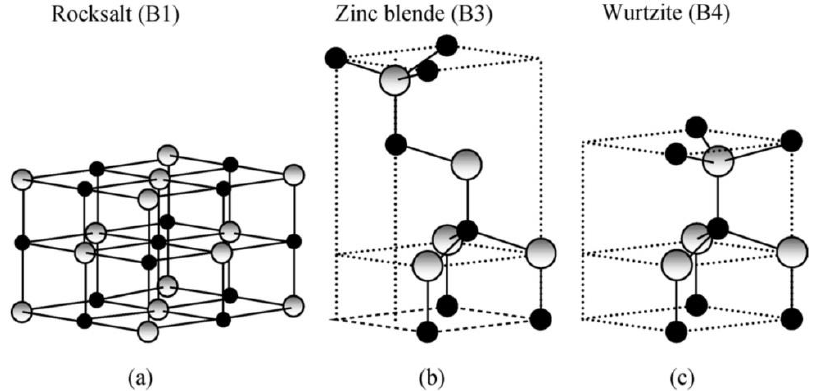
Figure 1. Stick and ball representation of ZnO crystal structures: ( a ) cubic rocksalt (B1), ( b ) cubic zinc blende (B3), and ( c ) hexagonal wurtzite (B4). The shaded grey and black spheres denote Zn and O atoms, respectively. Reprinted from [97], with the permission of John Wiley & Sons, Inc. Copyright 2009. All rights reserved. In order to re-use permission must be obtained from the rightsholder.